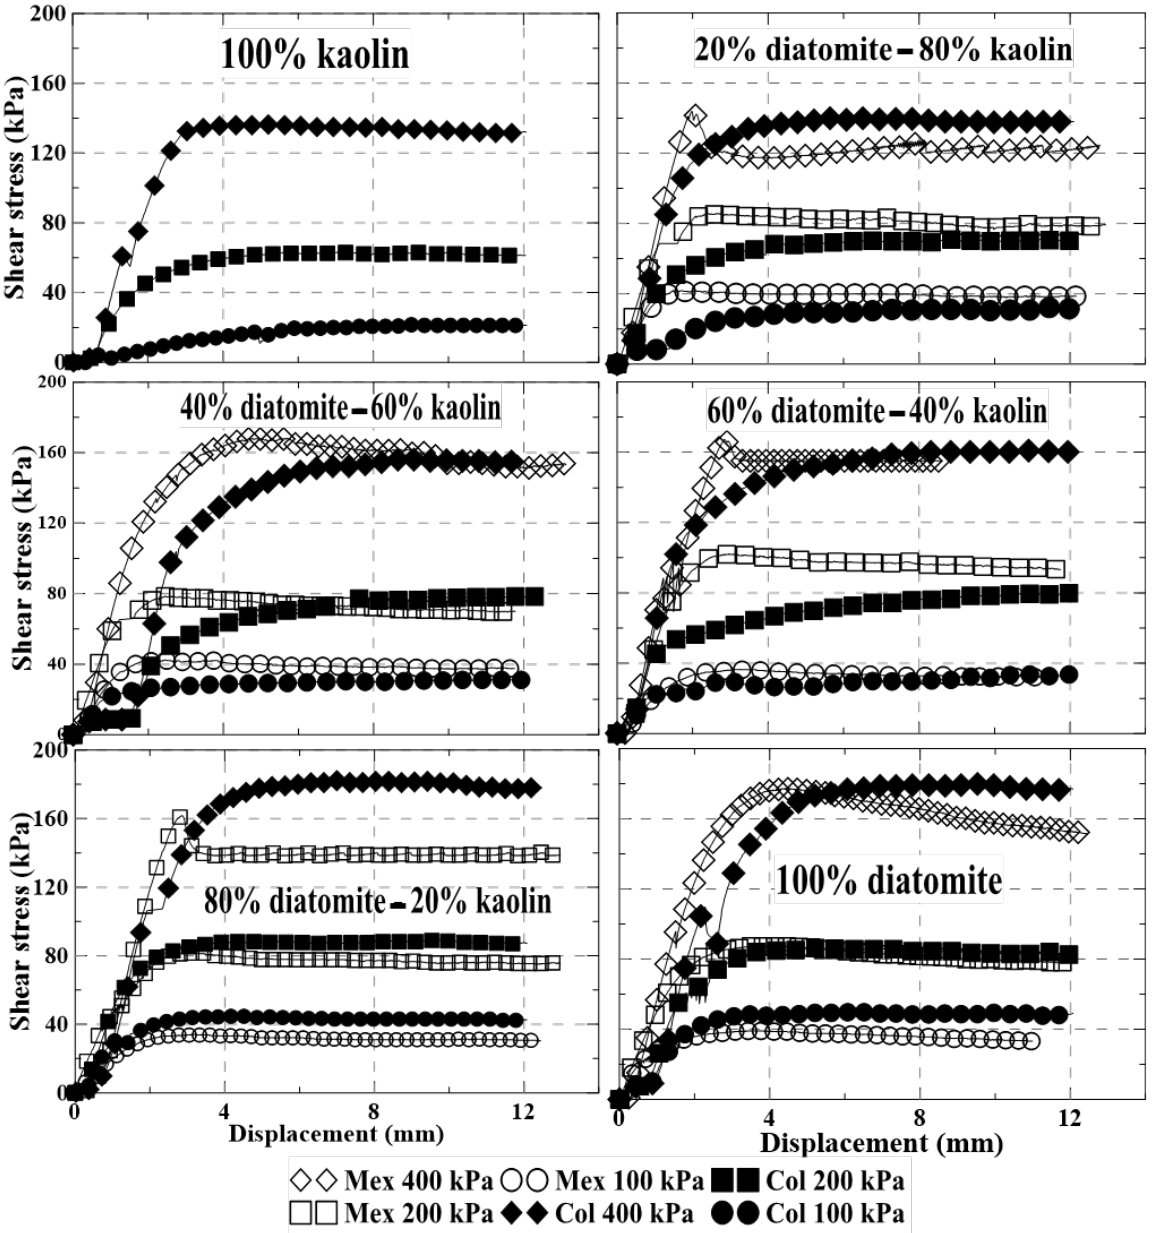
Figure 5. Illustrative example for shear stress vs. displacement curve.